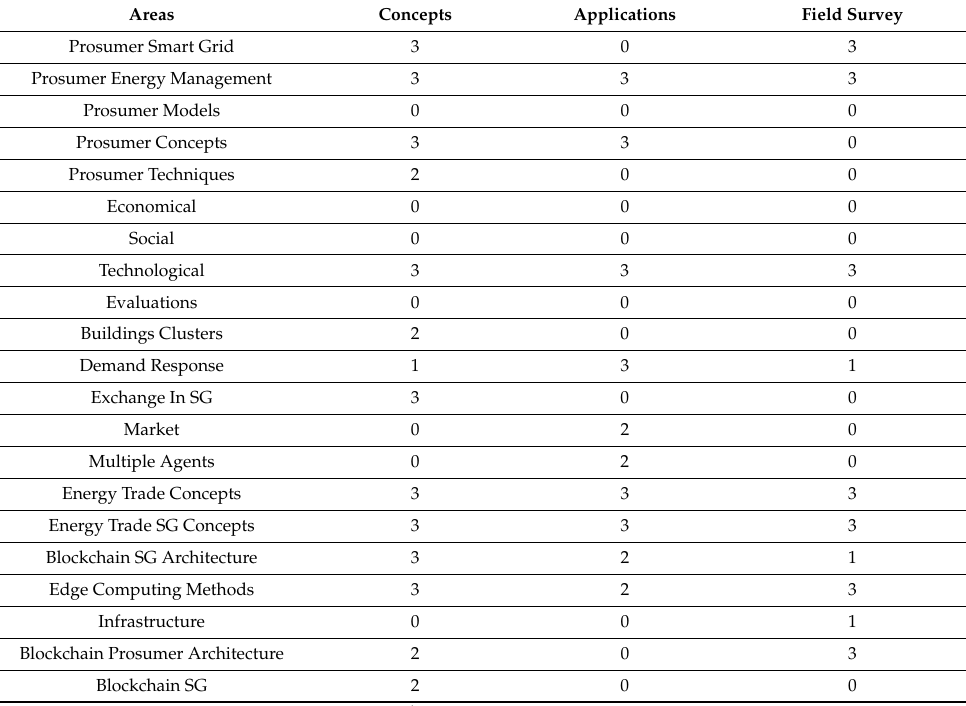
Table 1. Comparison of existing survey papers.